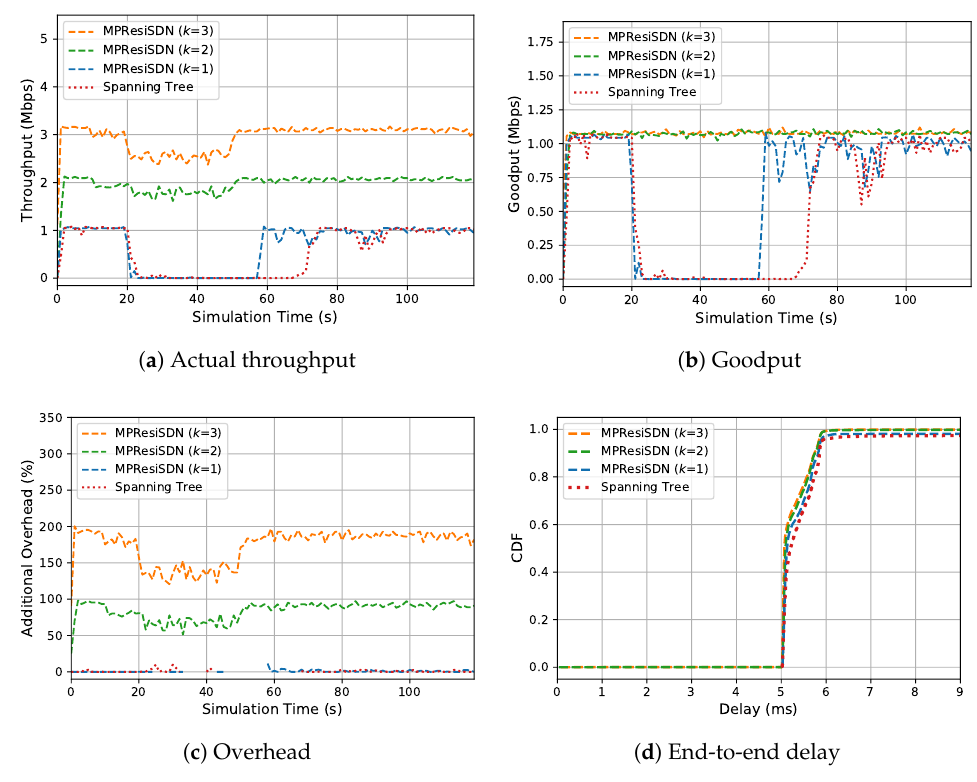
Figure 14. Comparison of the four strategies under the storm